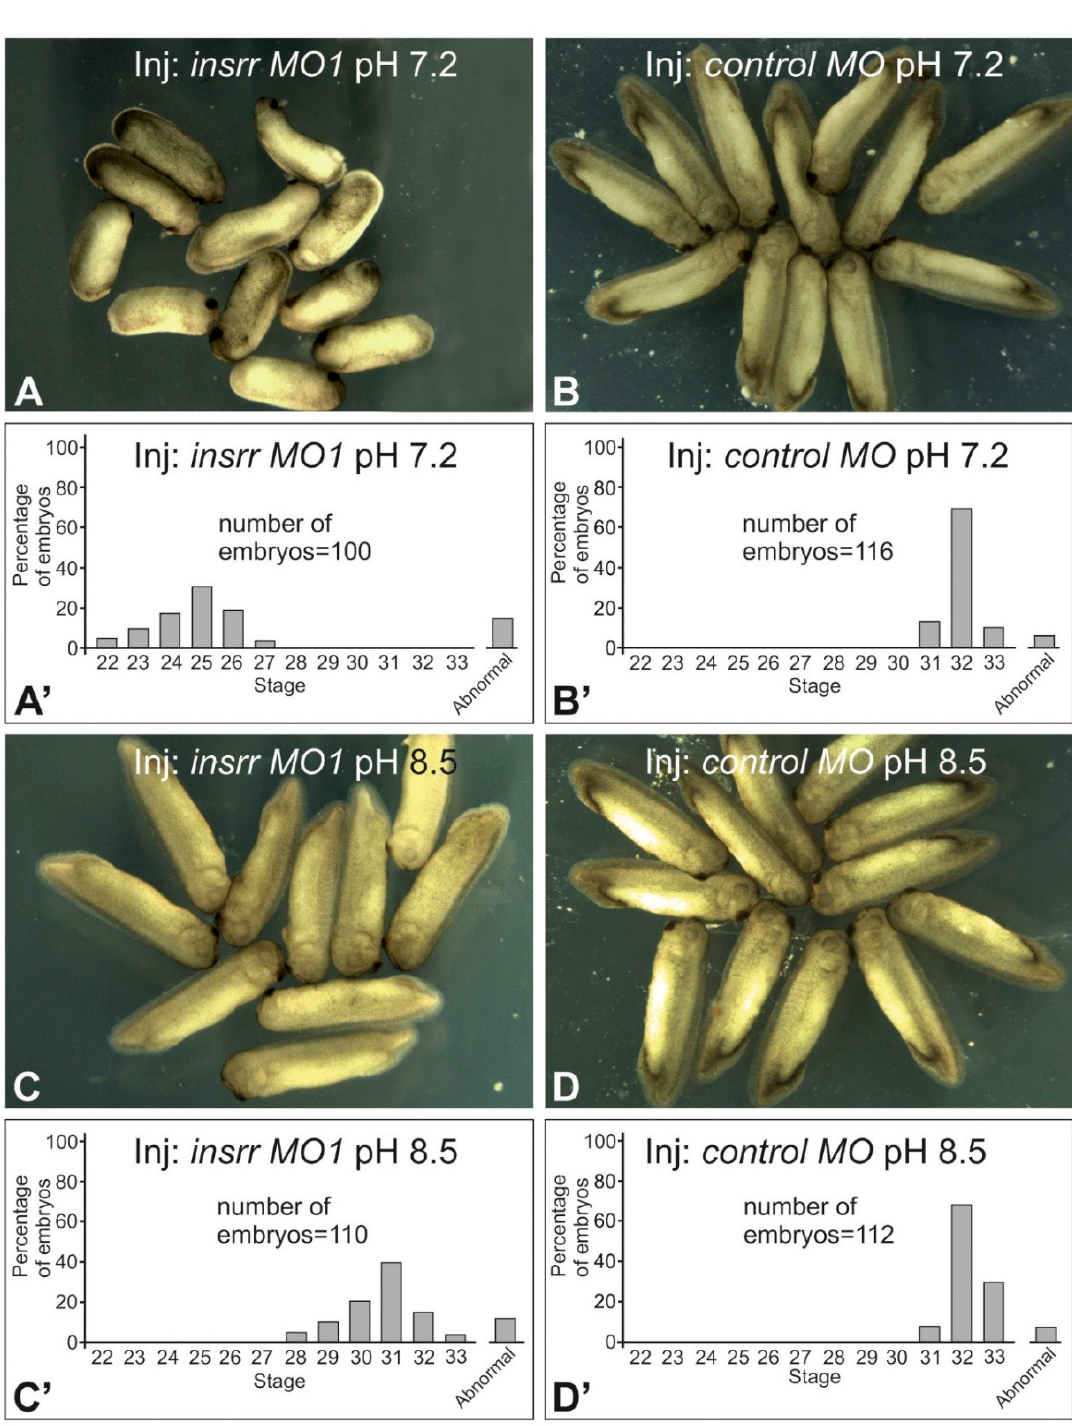
Figure 1. Downregulation of insrr by anti-sense morpholino injection retards the Xenopus laevis embryos’ development, whereas alkaline pH prevents this effect. ( A ). Embryos after injection of insrr MO1 at pH 7.2. ( B ). Embryos after injection of control MO at pH 7.2. ( C ). Embryos after injection of insrr MO1 at pH 8.5. ( D ). Embryos after injection of control MO at pH 8.5. The diagrams on ( A’ – D’ ) demonstrate the percentage distribution of embryos, some of which are shown on ( A’ – D’ ), by stage of development. As one may see, knockdown of insrr by insrr MO1 significantly retards the developmental rate of embryos comparing to their control siblings, and also distribution of the knocked-out embryos developed at pH 8.5 is significantly shifted towards the distribution seen in the wild-type siblings developed at pH 7.2 and pH